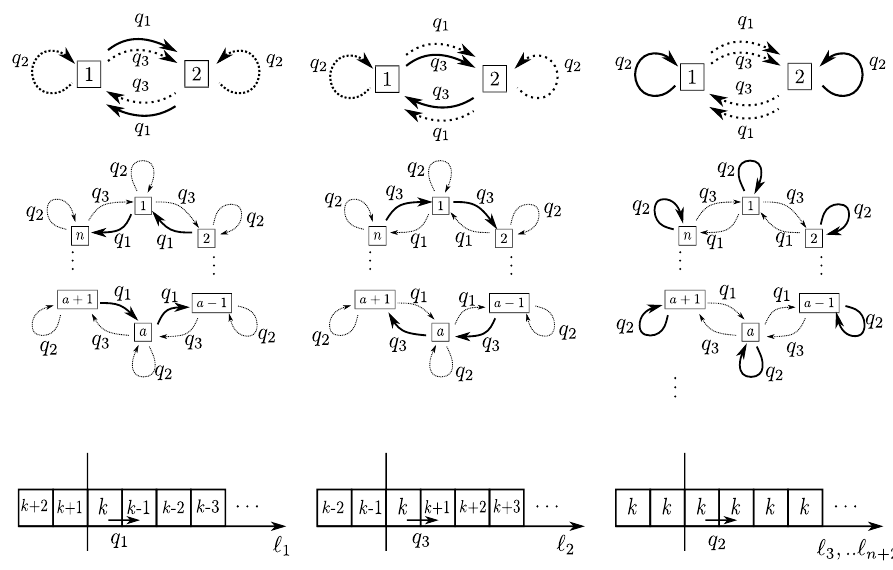
Figure 30. Similar to the two-dimensional crystal, the crystal structure does not change whether n = 2 or n > 2 , but the quiver structure changes. Left: subquiver and one-dimensional crystal associated with ‘ . Middle: subquiver and one-dimensional crystal associated with ‘ . Right: 1 2 subquiver and one-dimensional crystal associated with ‘ 3 , ..‘ n +2